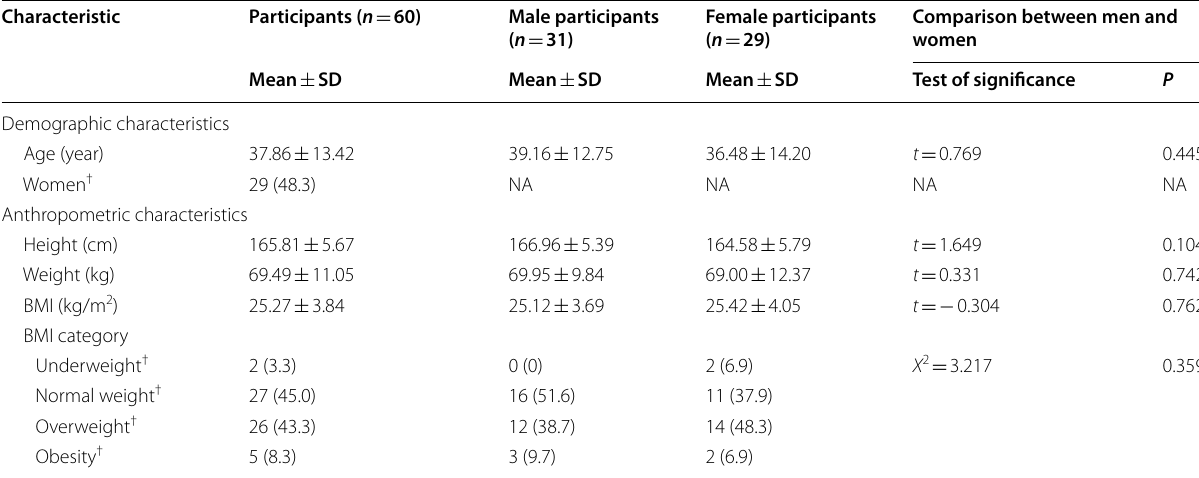
Table 1 Characteristic of the participated volunteers